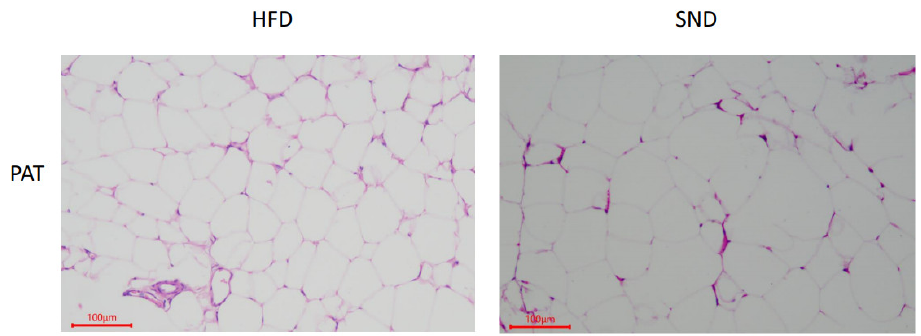
Figure 1. Hematoxylin-eosin staining of PAT in female rabbits fed SND ( n = 6) and HFD ( n = 6).